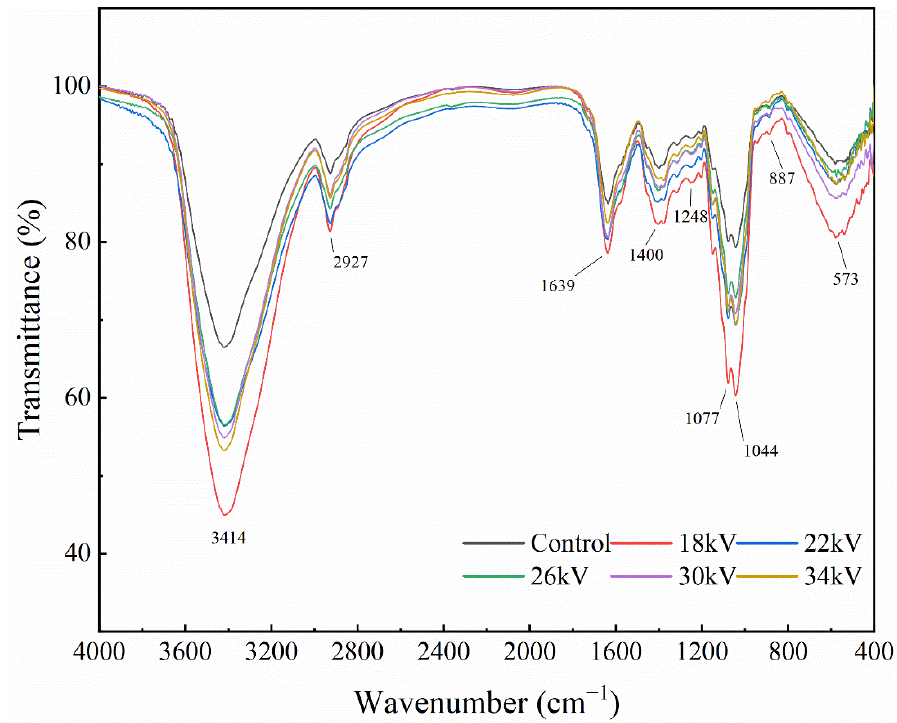
Figure 9. Infrared spectra of shiitake mushroom slices. FTIR spectra of dried shiitake mushroom slices displayed strong absorption